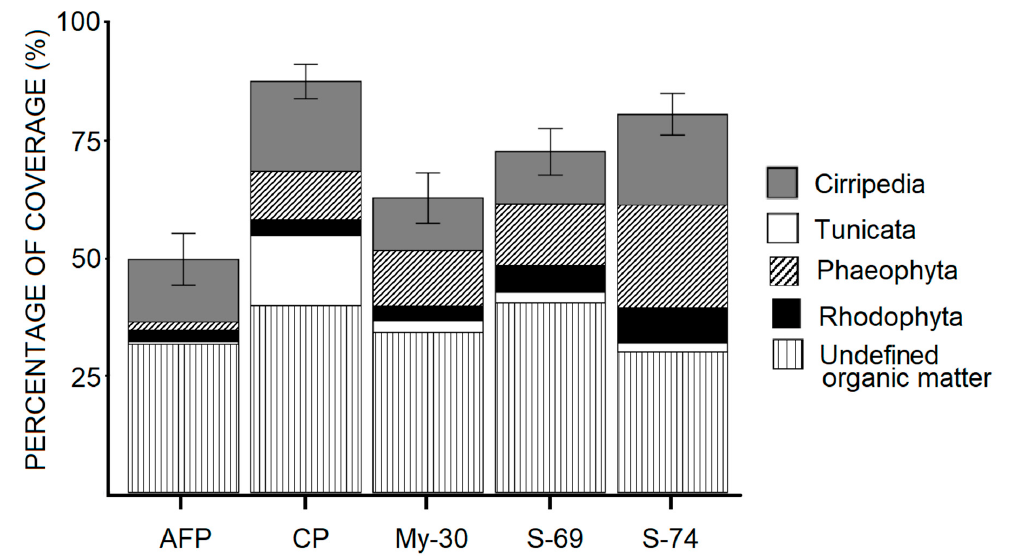
Figure 3. Percentage of epibiont coverage in di ff erent treatment plates after 130 days of exposure in the field (Marina La Paz). Antifouling Paint (AFP), control plate with formulated paint (CP), plates with Bacillus niabensis cell free culture supernatant (CFCS) (My-30, S-69) and plate with Ralstonia sp. CFCS (S-74).